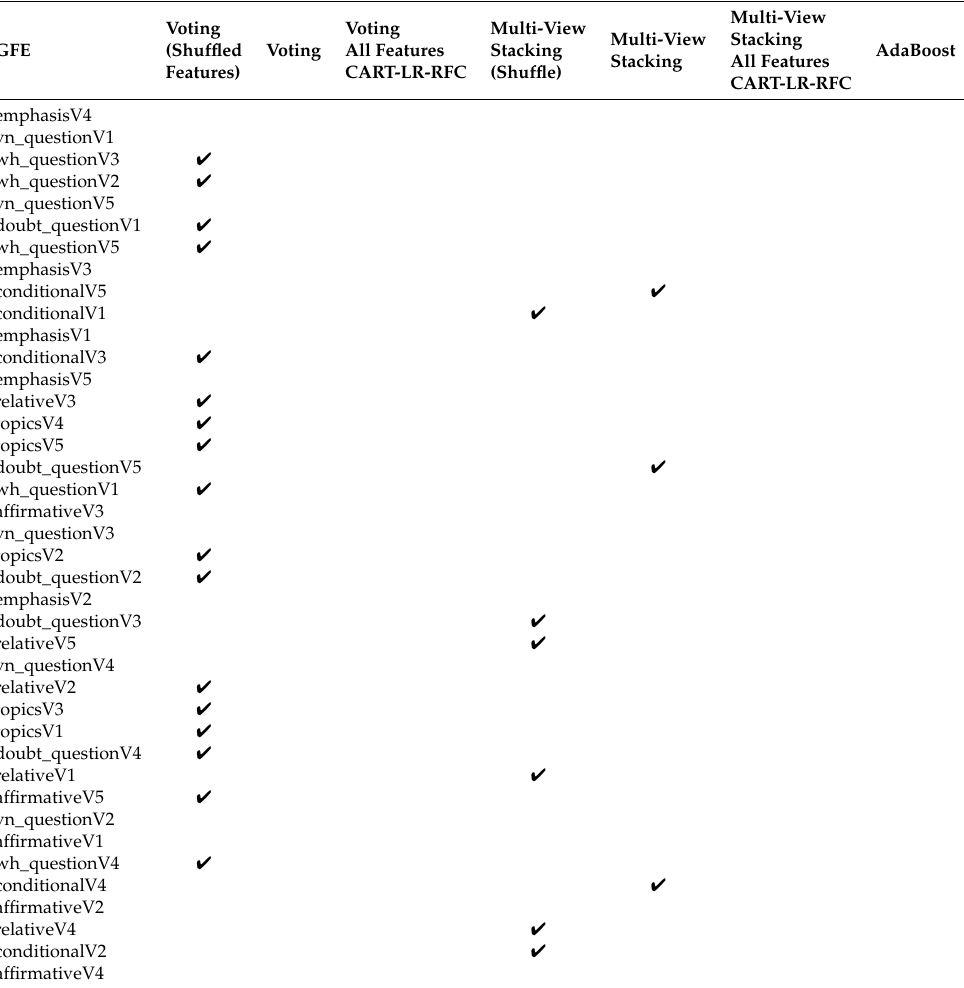
Table 10. Best fusion method for each GFE data set. A tick ( (cid:52) ) marks the best configuration when it is statistical-significantly better than aggregation. RFC = Random Forest; LR = Logistic Regression; CART = Decision